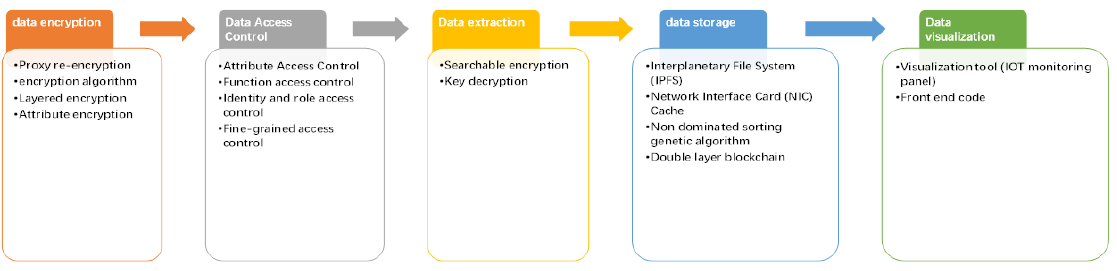
Figure 2. Division and reconstruction diagram of IoT data flow module.